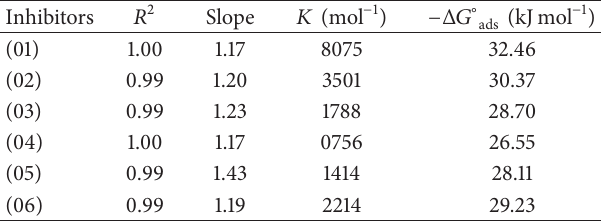
for the mild steel ads SO and in the absence and presence of 2 4